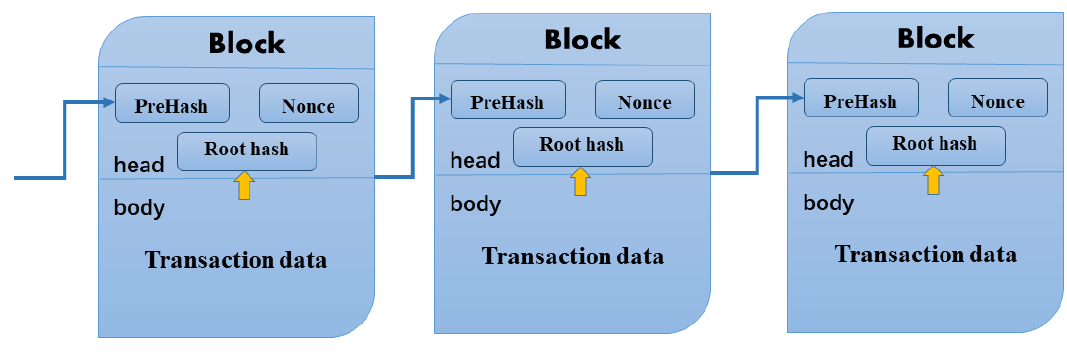
Figure 1. Illustration of Blockchain